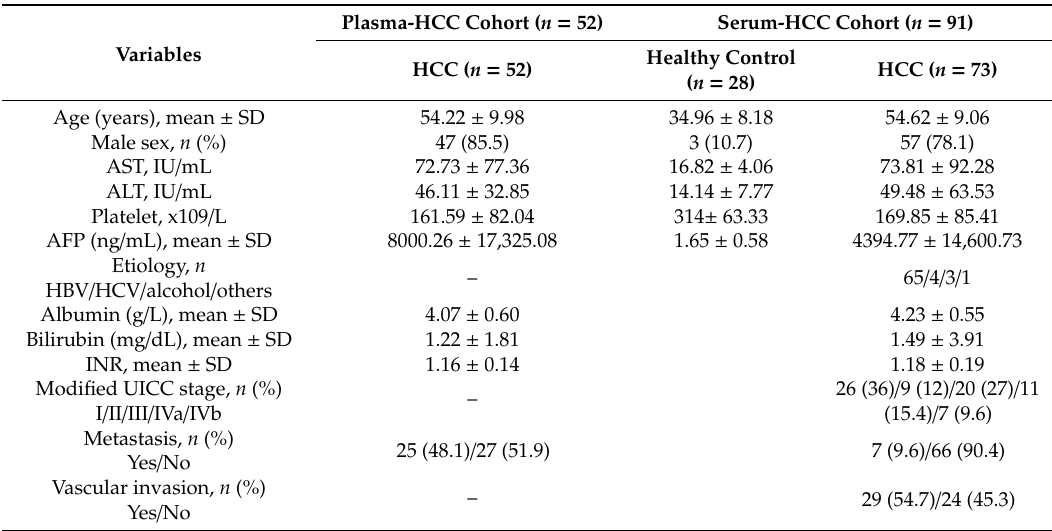
Table 1. Baseline characteristics of the Plasma-HCC cohort and the Serum-HCC